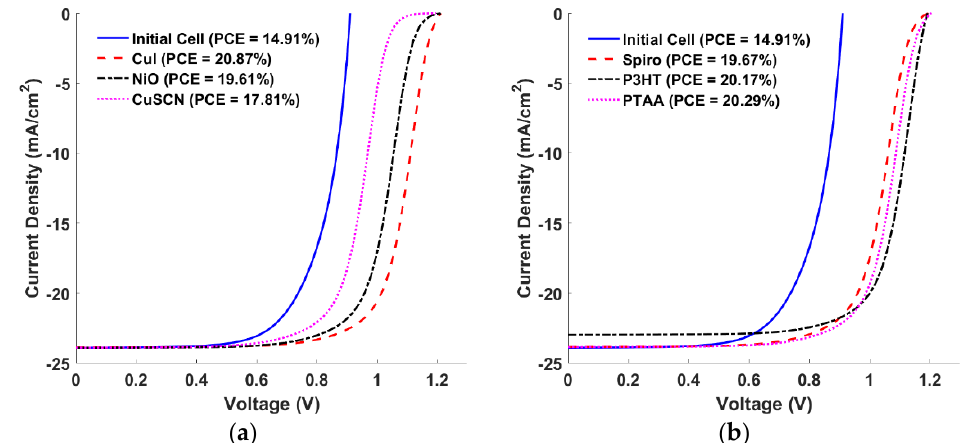
Figure 5. J-V curves for different materials of a single HTL. ( a ) Inorganic and ( b ) Organic.